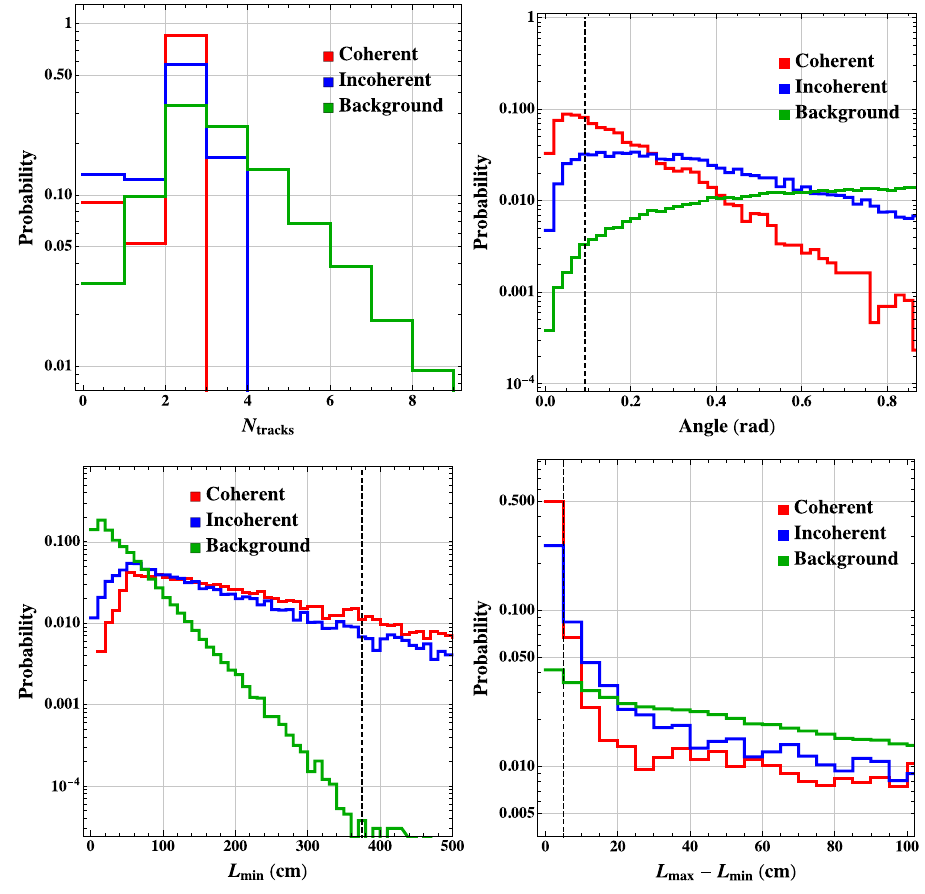
Fig. 15 Event kinematic distributions of signal and background considered for the selection of muonic trident interactions in the ND LArTPC: number of tracks (top left), angle between the two main tracks (top right), length of the shortest track (bottom left), and the difference in length between the two main tracks (bottom right). The dashed, black vertical lines indicate the optimal cut values used in the